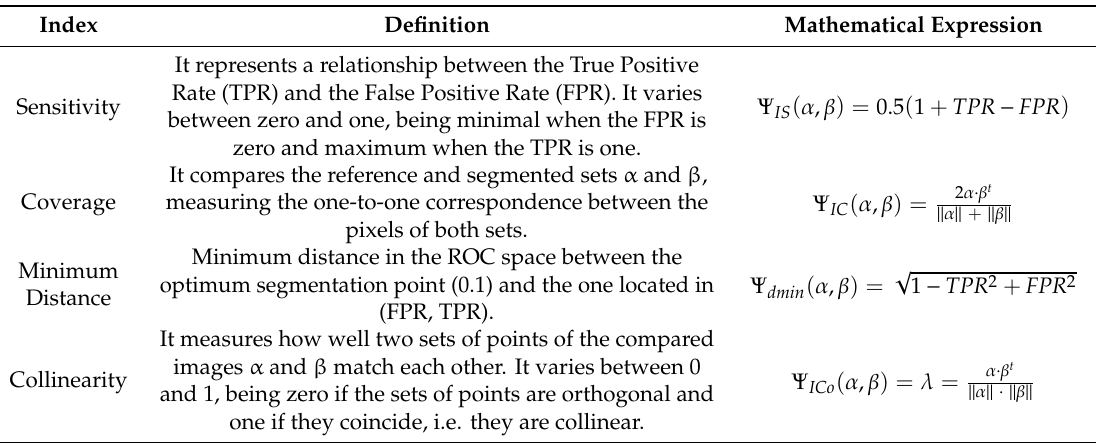
Table 1. Definition of the similarity and distance indices used for tuning the Parametric Segmentation Tuning